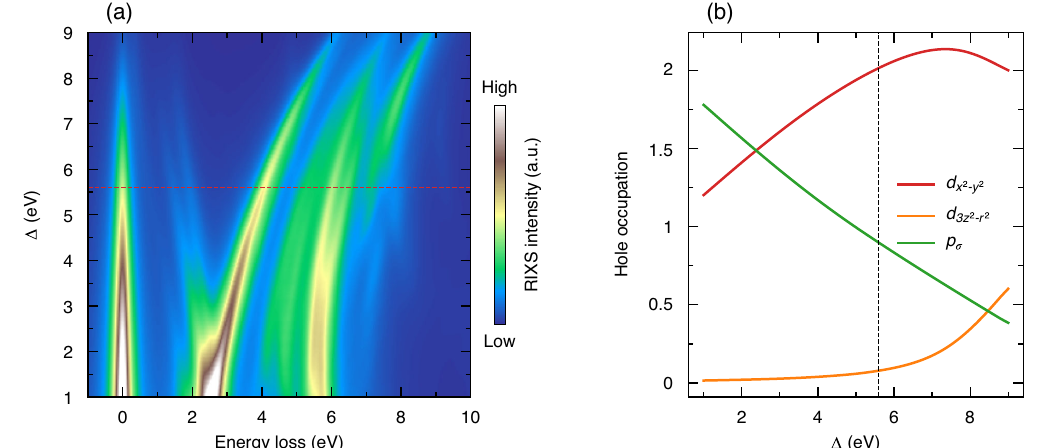
FIG. 6. Ni 2 O 7 cluster calculations with different Δ . Other parameters are fixed according to Table II. (a) Intensity map presenting the calculated Δ -dependent RIXS spectra with θ ¼ 60 ° and σ polarization. (b) Orbital occupation of holes with different Δ in a doped cluster (three holes) with U ¼ 6 . 5